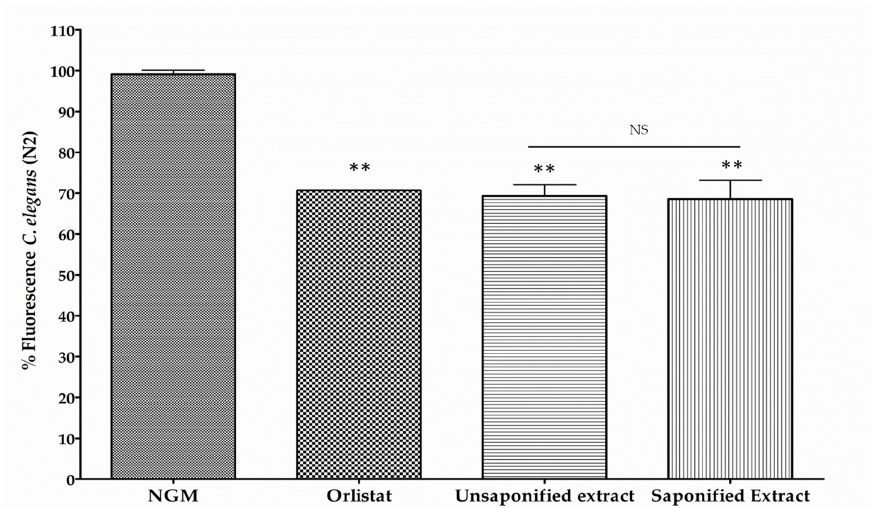
Figure 3. Measurement of fluorescence in Nile Red stained C. elegans worms fed with non ‐ saponified or saponified carotenoid extracts from mandarin juice adjusted to contain 0.025 μ g/mL of β‐ Cryptoxanthin (BCX). Nematode growth medium (NGM) was used as control feeding condition and Orlistat (6 μ g/mL) as positive control. Percentage of fluorescence is the mean of two independent experiments. ** p ‐ value ≤ 0.01, NS: not significant. Table 1. Carotenoid content and composition in saponified and non ‐ saponified juice extracts of Clementine mandarins. The percentage of β‐ Cryptoxanthin over the total amount of carotenoids is indicated in parenthesis. Carotenoid Concentration ( μ g/mL) in Mandarin Juice Extract 1 Saponified